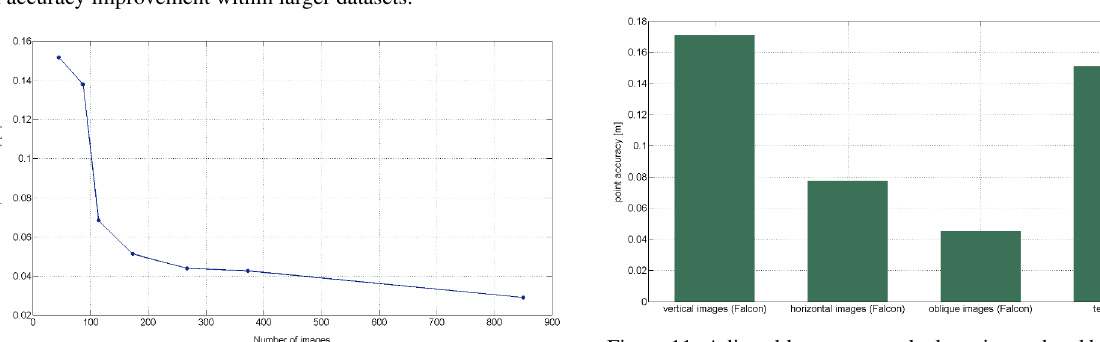
Figure 10: Error curve for different image subsets. With increas- ing total number of images used for the reconstruction, the mean point error decreases.